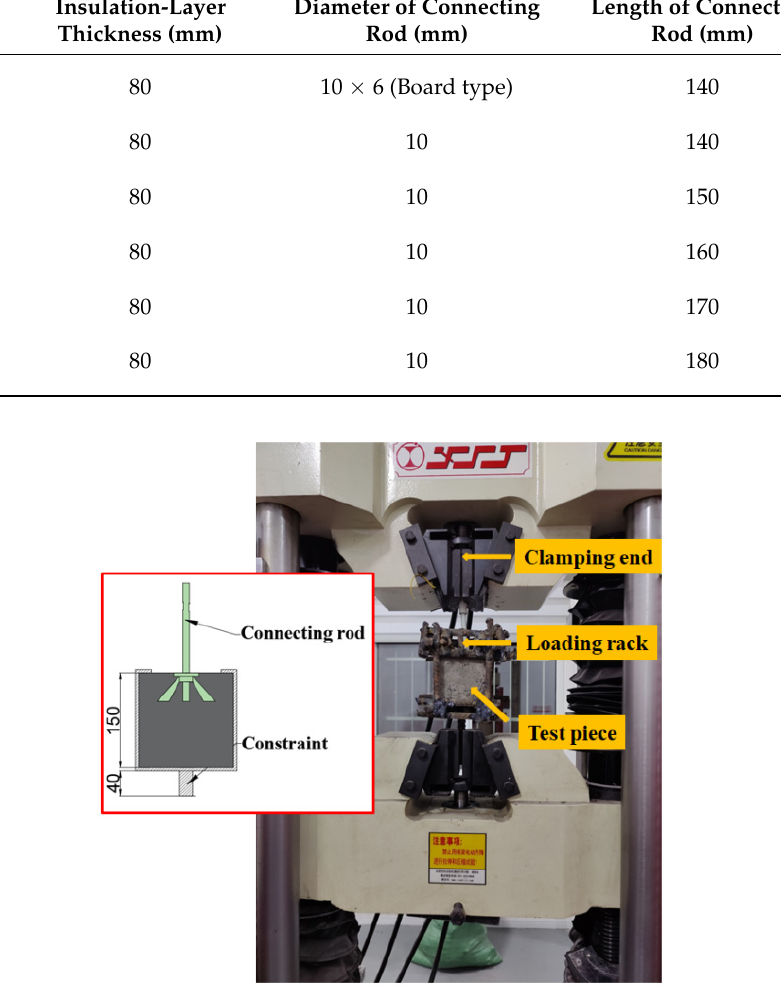
Figure 3. Schematic diagram of the pull-out-specimen structure (Unit: mm).